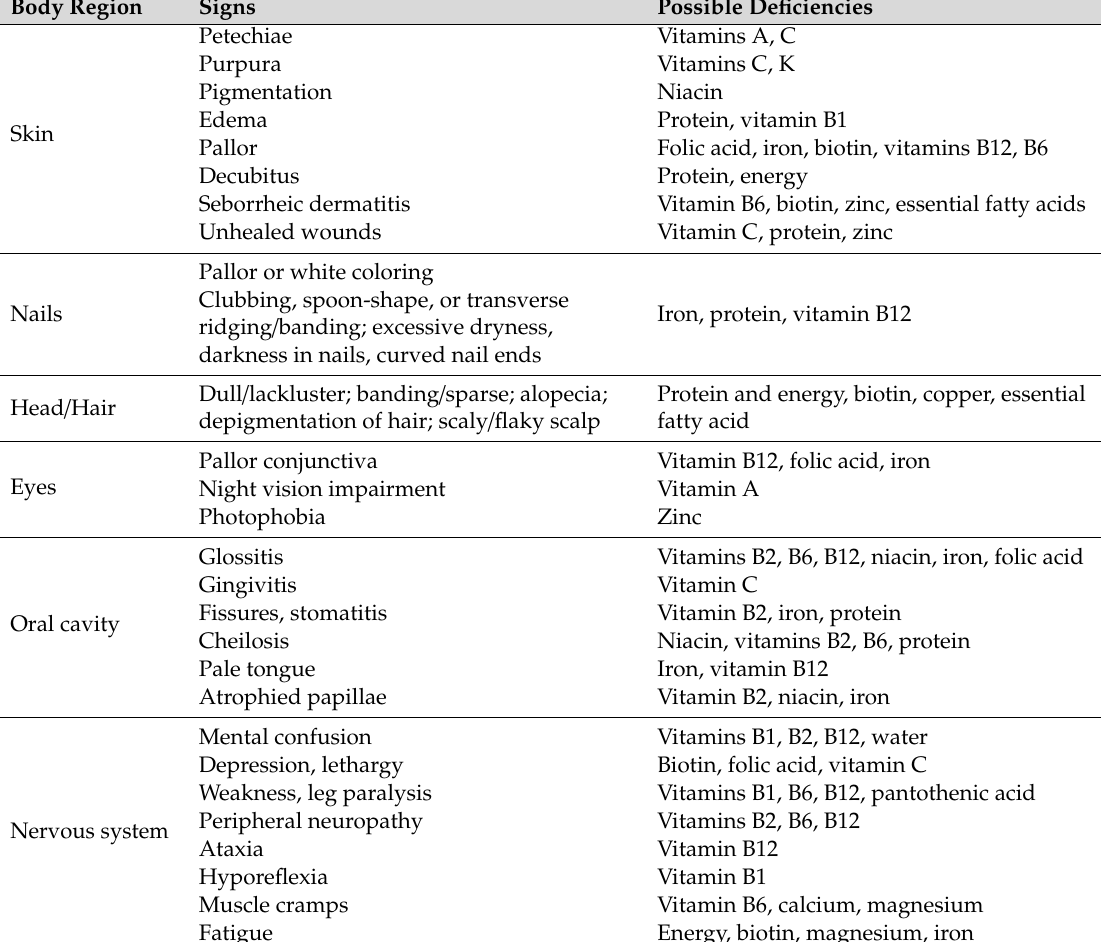
Table 6. Clinical signs and symptoms of micronutrient deficiencies